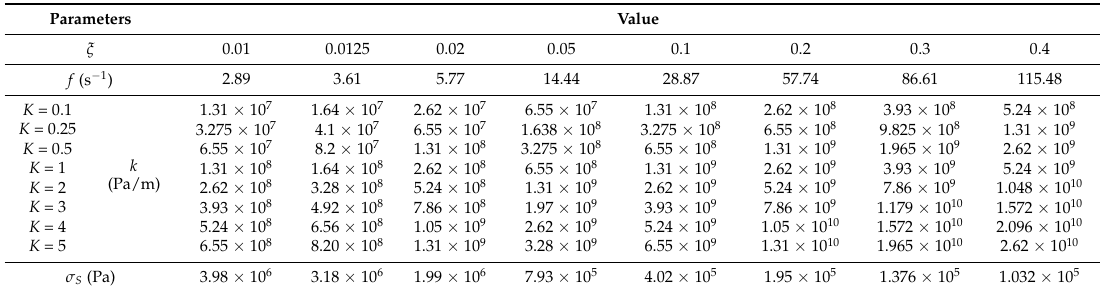
Table 3. Scheme for the properties of joints and applied stress under the bottom of the slope used in the FLAC model.